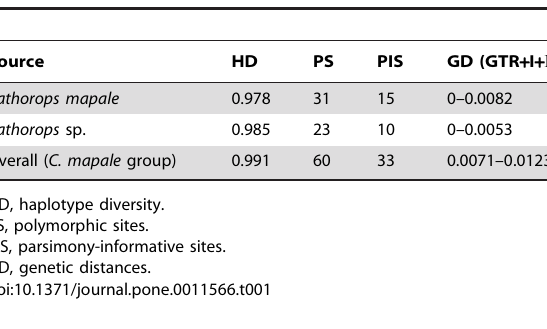
Table 1. Summary of sequence variation statistics and genetic distances for the Cathorops mapale